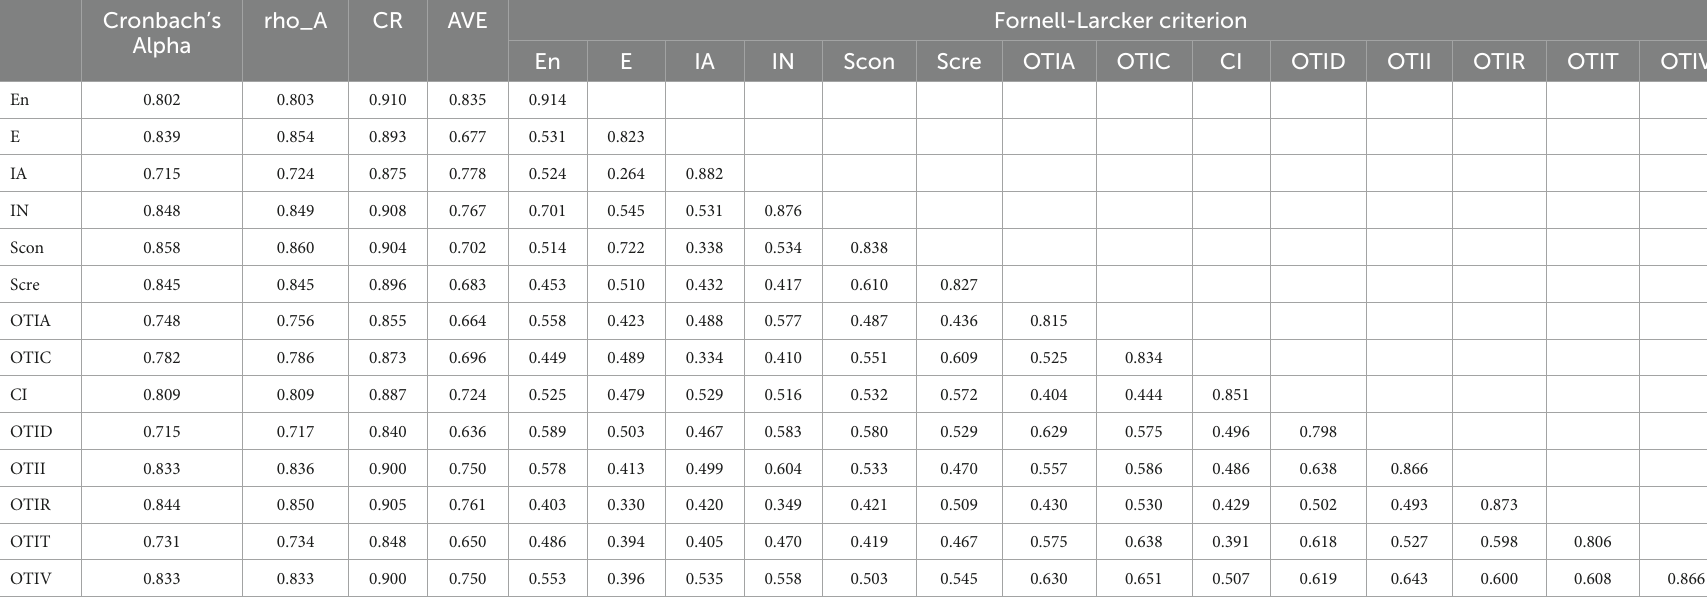
TABLE 3 Reliability, validity, and Fornell-Larcker